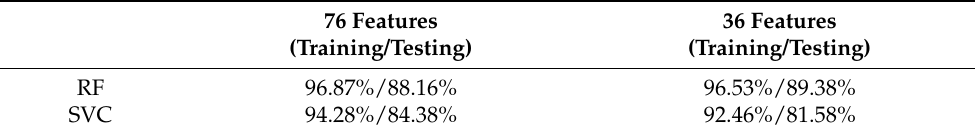
Table 13. Multiclass classification accuracy (CSE-CIC-IDS